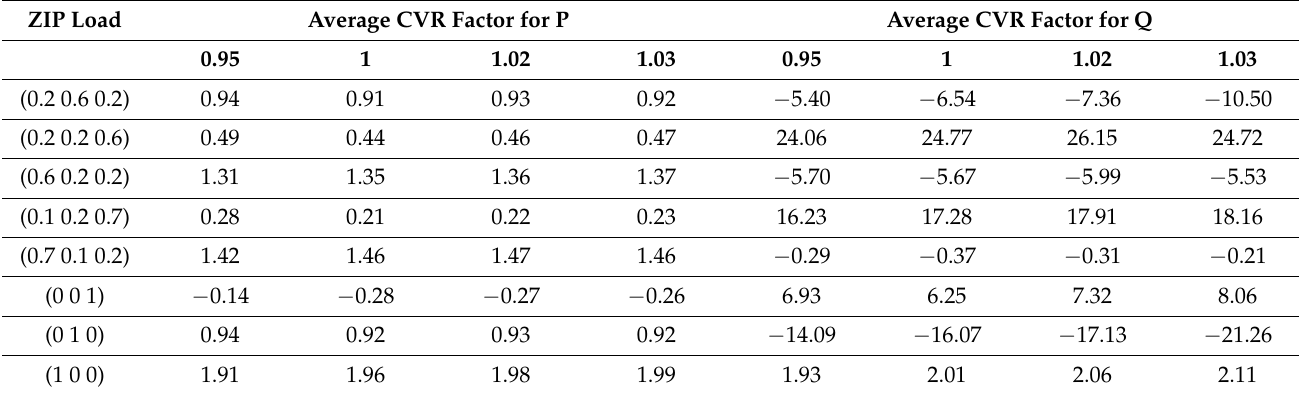
Table 8. Average CVR factor using power captured at substation for case